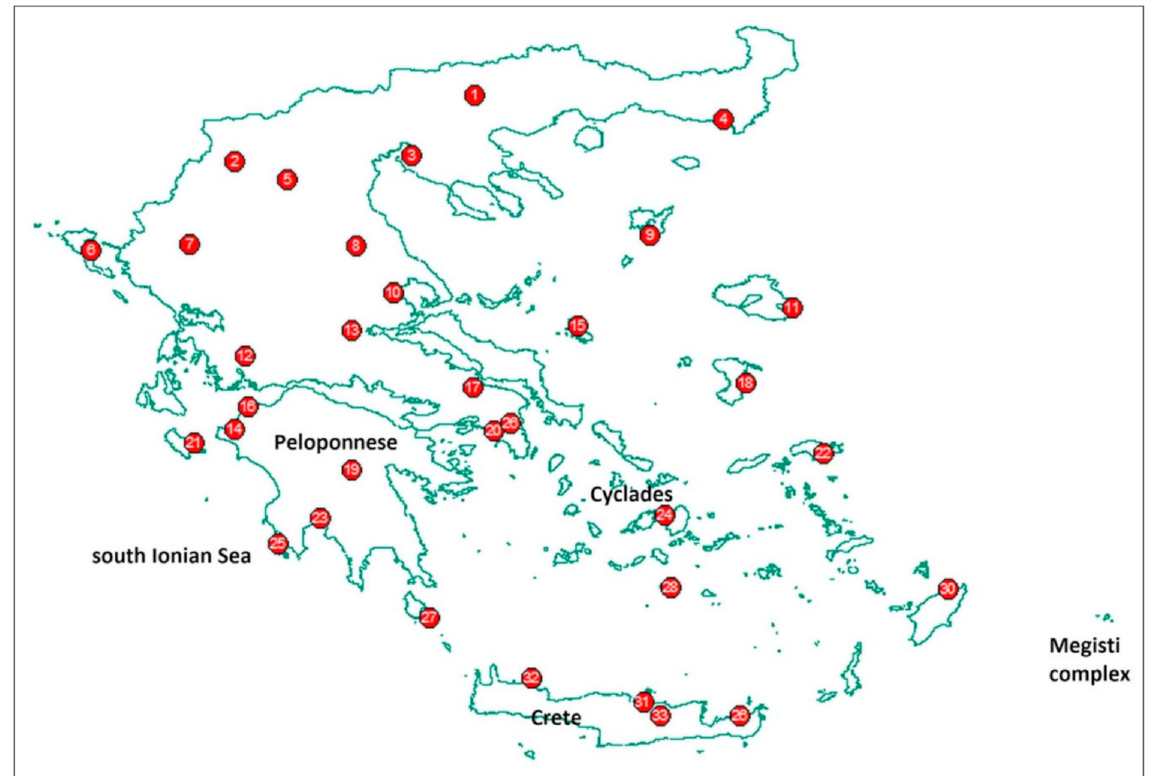
Figure 1. Distribution of the 33 selected HNMS stations (red circles) over Greece. The numbers within the circles refer to their names in column 1 of Table 2. The regions of south Ionian Sea, Peloponnese, the Cyclades (islands), Crete, and Megisti complex (of islands) are also shown; the Megisti complex is also known as the Kastellorizo complex, a complex of 14 small islands/rocky